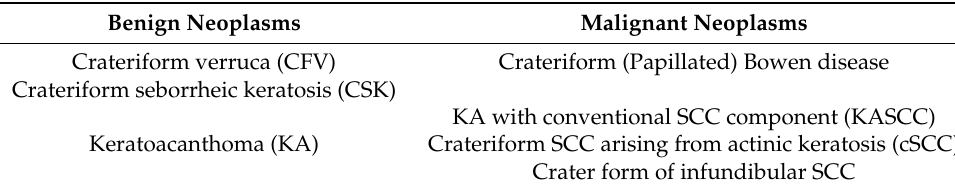
Table 1. Our classification of epithelial crateriform tumors. Benign Neoplasms Malignant Neoplasms Crateriform verruca (CFV) Crateriform (Papillated) Bowen disease Crateriform seborrheic keratosis (CSK) KA with conventional SCC component (KASCC) Keratoacanthoma (KA) Crateriform SCC arising from actinic keratosis (cSCC) Crater form of infundibular SCC SCC: squamous cell